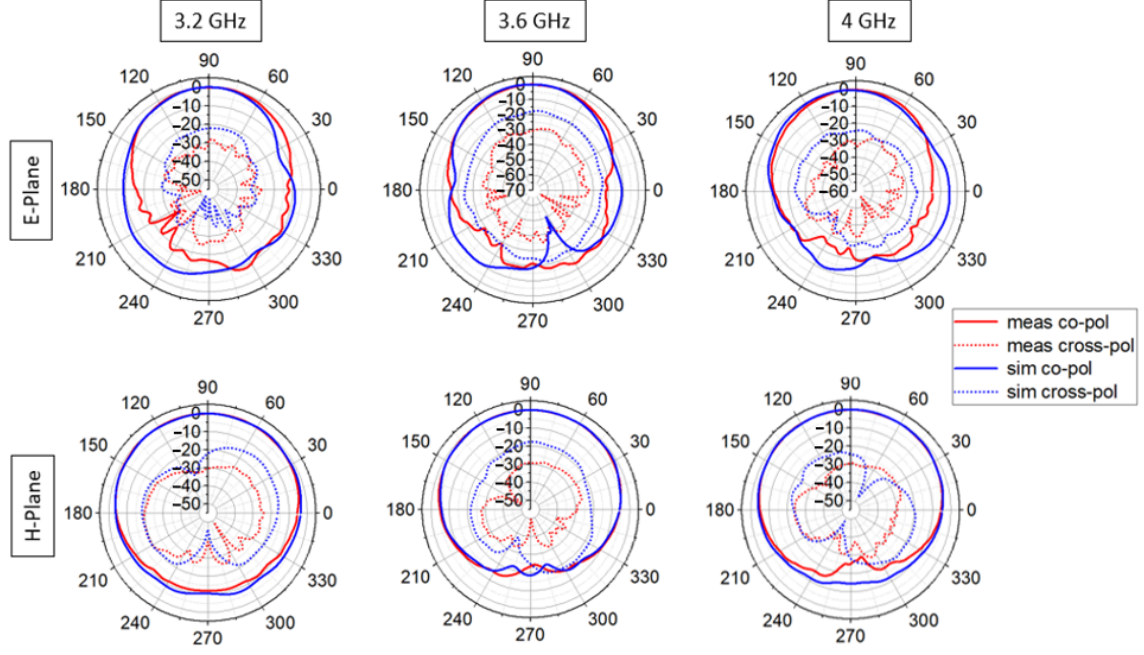
Figure 11. Simulated and measured radiation patterns (gain in dB) of the fabricated prototype of the proposed antenna 1.